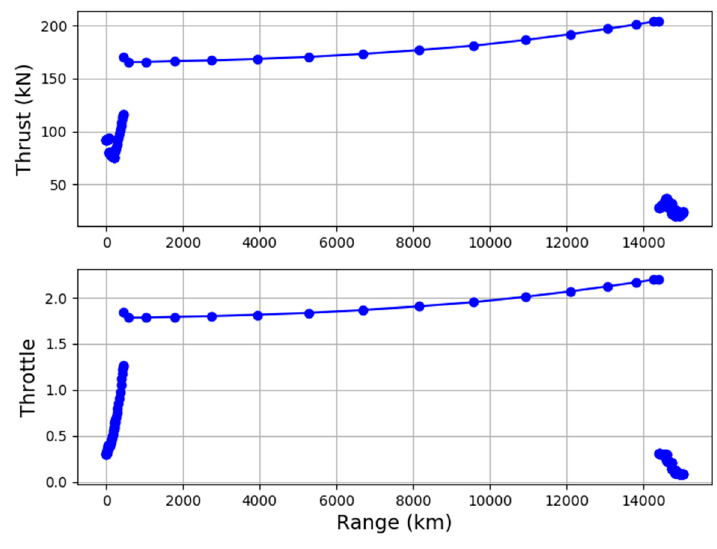
Figure A9. Thrust and throttle settings of SE 2 A-LR. Table A3. Weight break-down of SE 2 A-LR calculated using SUAVE after